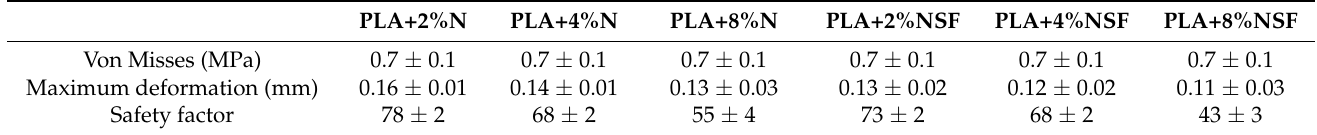
Table 6. Simulation results for commercial materials.